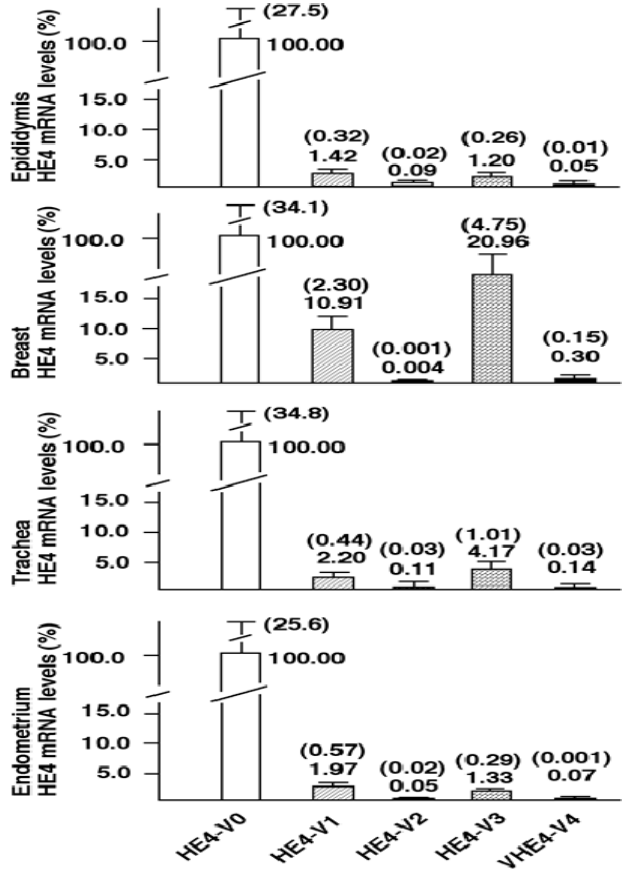
Figure 4. Comparison of HE4 variant expression levels in normal tissues. The data from Figure 3 was re-set to best describe the HE4 variant expression levels in epididymis, breast, trachea and endometrium. The relative expression levels were converted based on HE4 -V0 (set as 100). Average and standard errors were indicated by the number on the top of